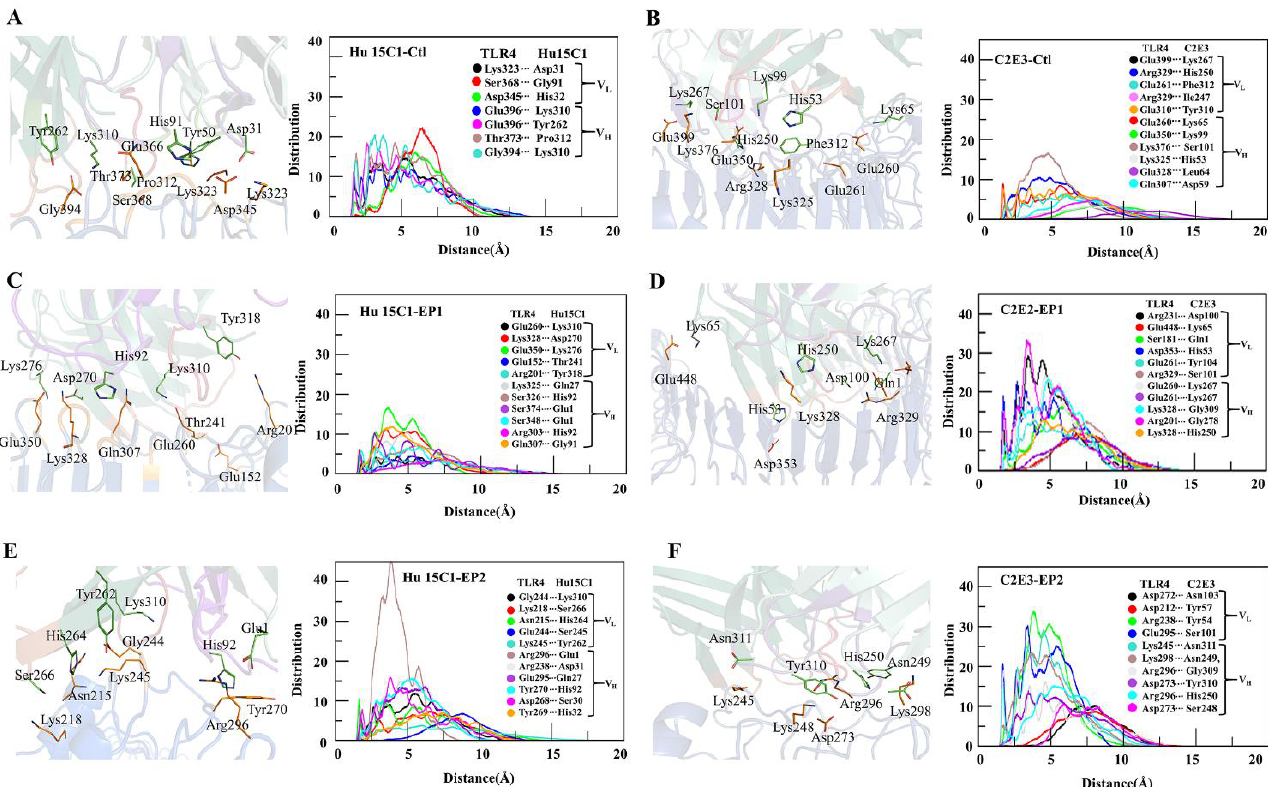
Figure 4. Distribution of minimum distances between the residues of Hu 15C1 and C2E3 interacting with TLR4 at sites ( A , B ) Ctl, ( C , D ) EP1, and ( E , F ) EP2.